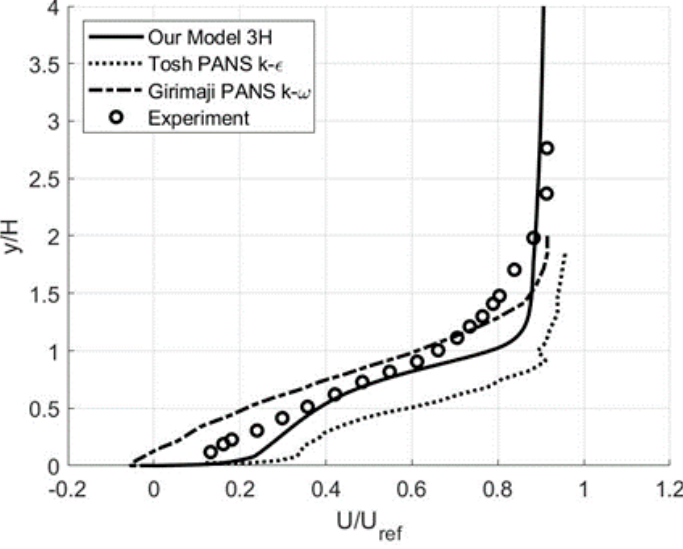
Figure 7. Mean velocity profiles at x / H = 6 from the step ( f ε = 0.667, f k = 0.2 ) . The mean turbulent kinetic energy profiles at x / H of 2 and 5 are given in Figures 8 and 9. At both locations, our model predictions are in better agreement with the experimental data.